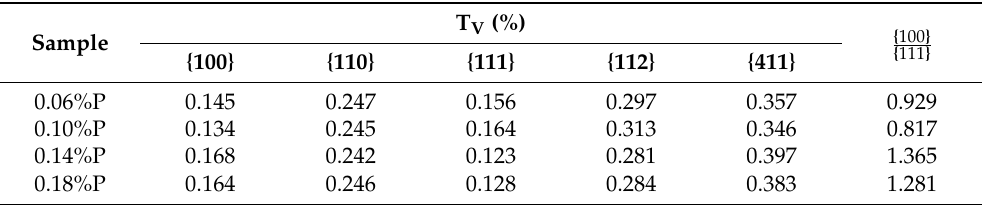
Table 3. The content of the main texture components in different target P contents of the experimental steel (volume ratio/%, deviation angle < 15 ◦